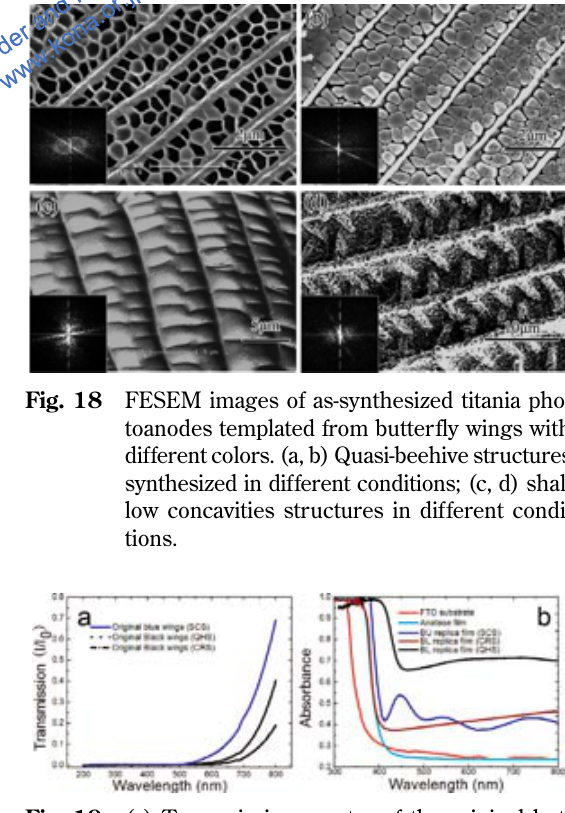
Fig. 19 (a) Transmission spectra of the original but- terfly wings: Continuous line (blue), short dash dot line (black wings with cross-ribbing structure), dot line (black wings with quasi- honeycomb structure). (b) The wavelength- dependent absorption (at normal incidence). Different colors represent different samples (cutline shown in the upper right